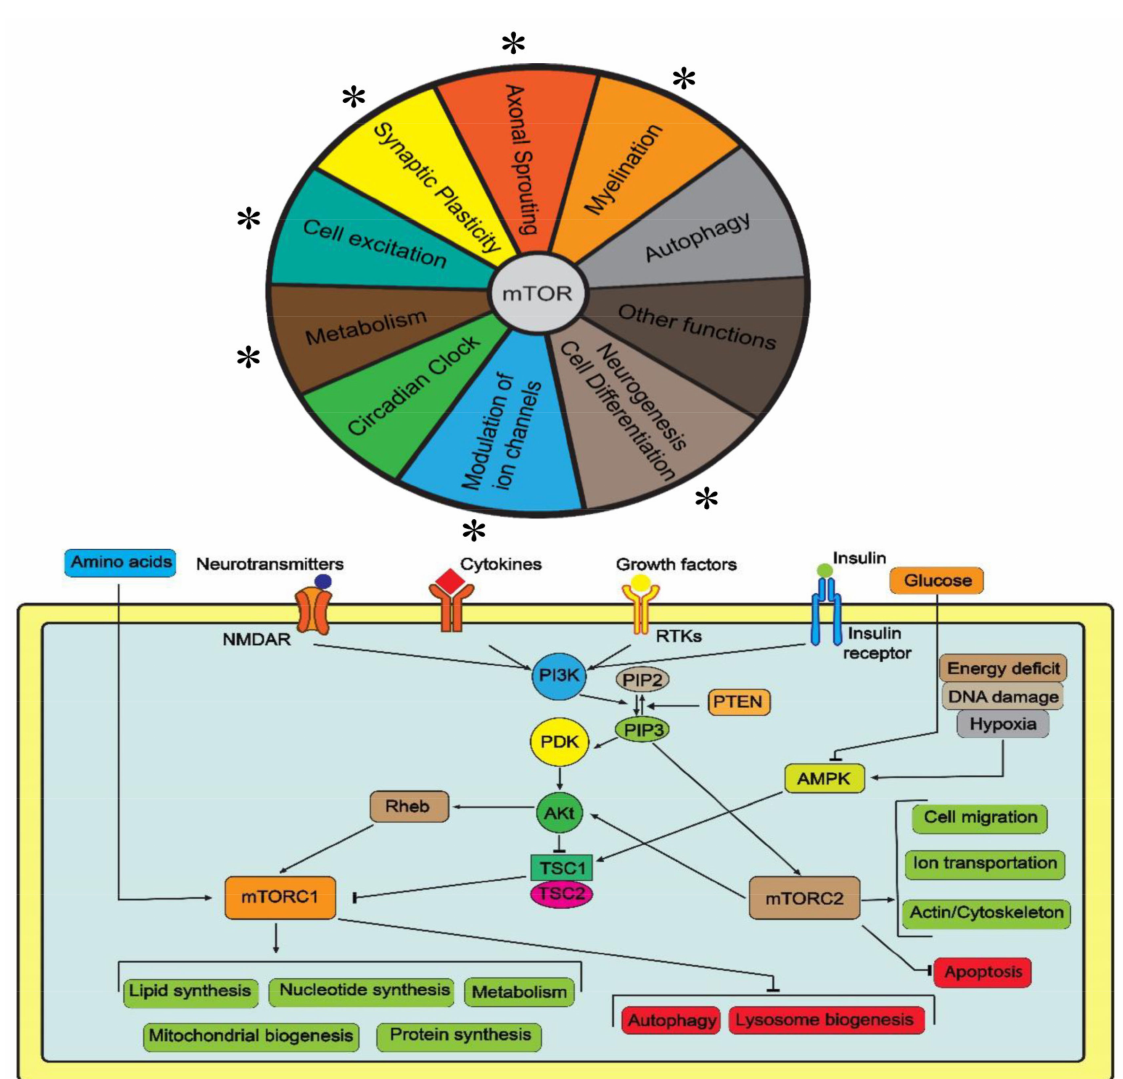
Figure 1. A brief summary of the mTOR signaling pathway, its mediation of cellular processes and their relevance to epilepsy (* denotes high